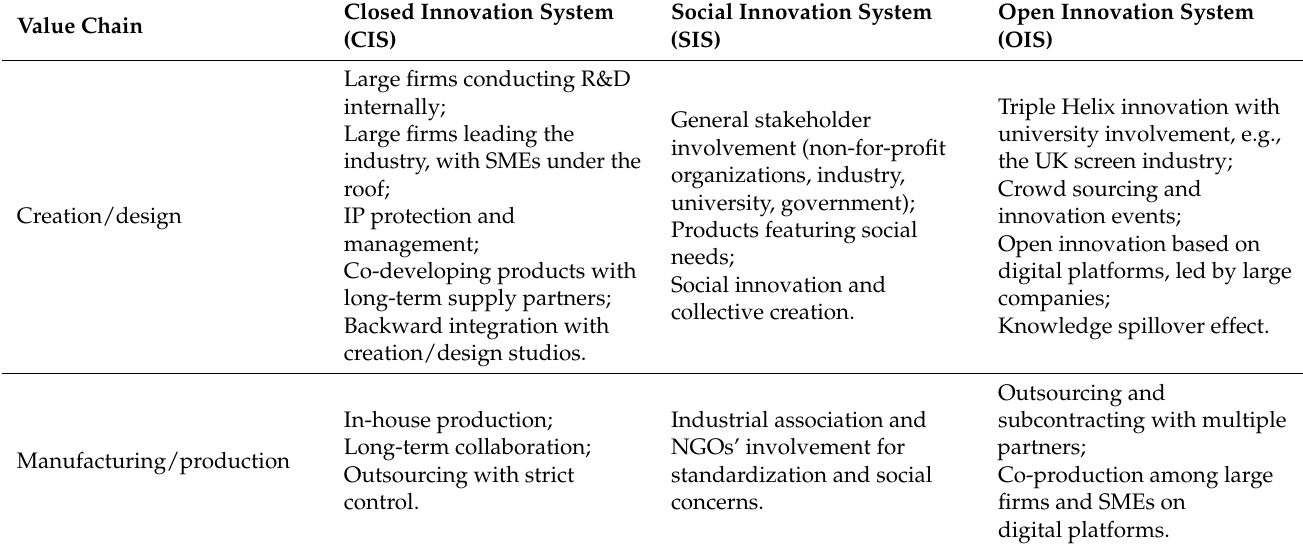
Table 3. Features of three types of macro innovation systems in the animation